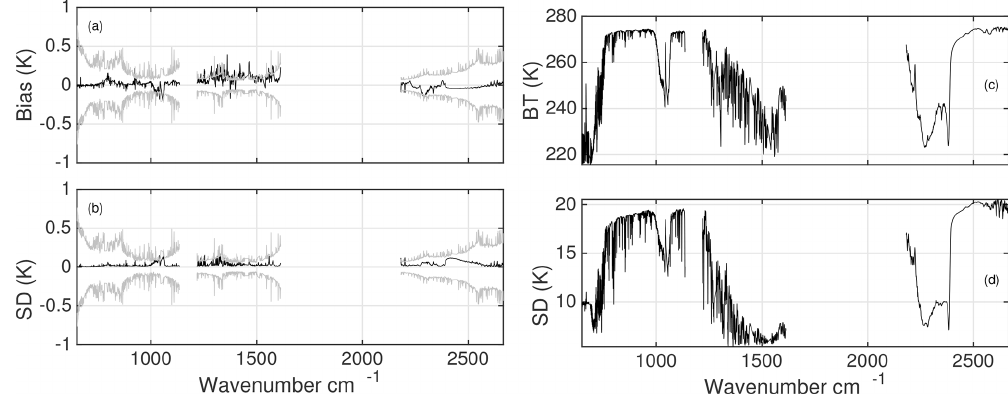
Figure 4. Results for 49 regression profiles, with 42 molecular gases and 13 cross-section gases, convolved using AIRS SRFs. The emissivity was set to 1.0 and a 22 ◦ satellite scan angle. Panels (a, b) show the AIRS SRF convolved differences using the monochromatic differences (LBLRTM – kCARTA) seen in Fig. 3, but here with all gases added, and are due primarily to the different spectroscopy used by the two RTAs (except for the CO 2 and CH 4 gases); the grey curves are the AIRS NeDT at 250K. Panels (c, d) show the mean calculated brightness temperature and standard deviation computed over 49 profiles. The variation in the 800–1200cm − 1 region (and 2400–2680cm − 1 ) is due to surface temperature differences and column water, while the variation in the other regions such as 10 and 7.6µm is due to differing gas profiles of O 3 and H 2 O; the variation in the 4 and 15µm regions is due to temperature profile